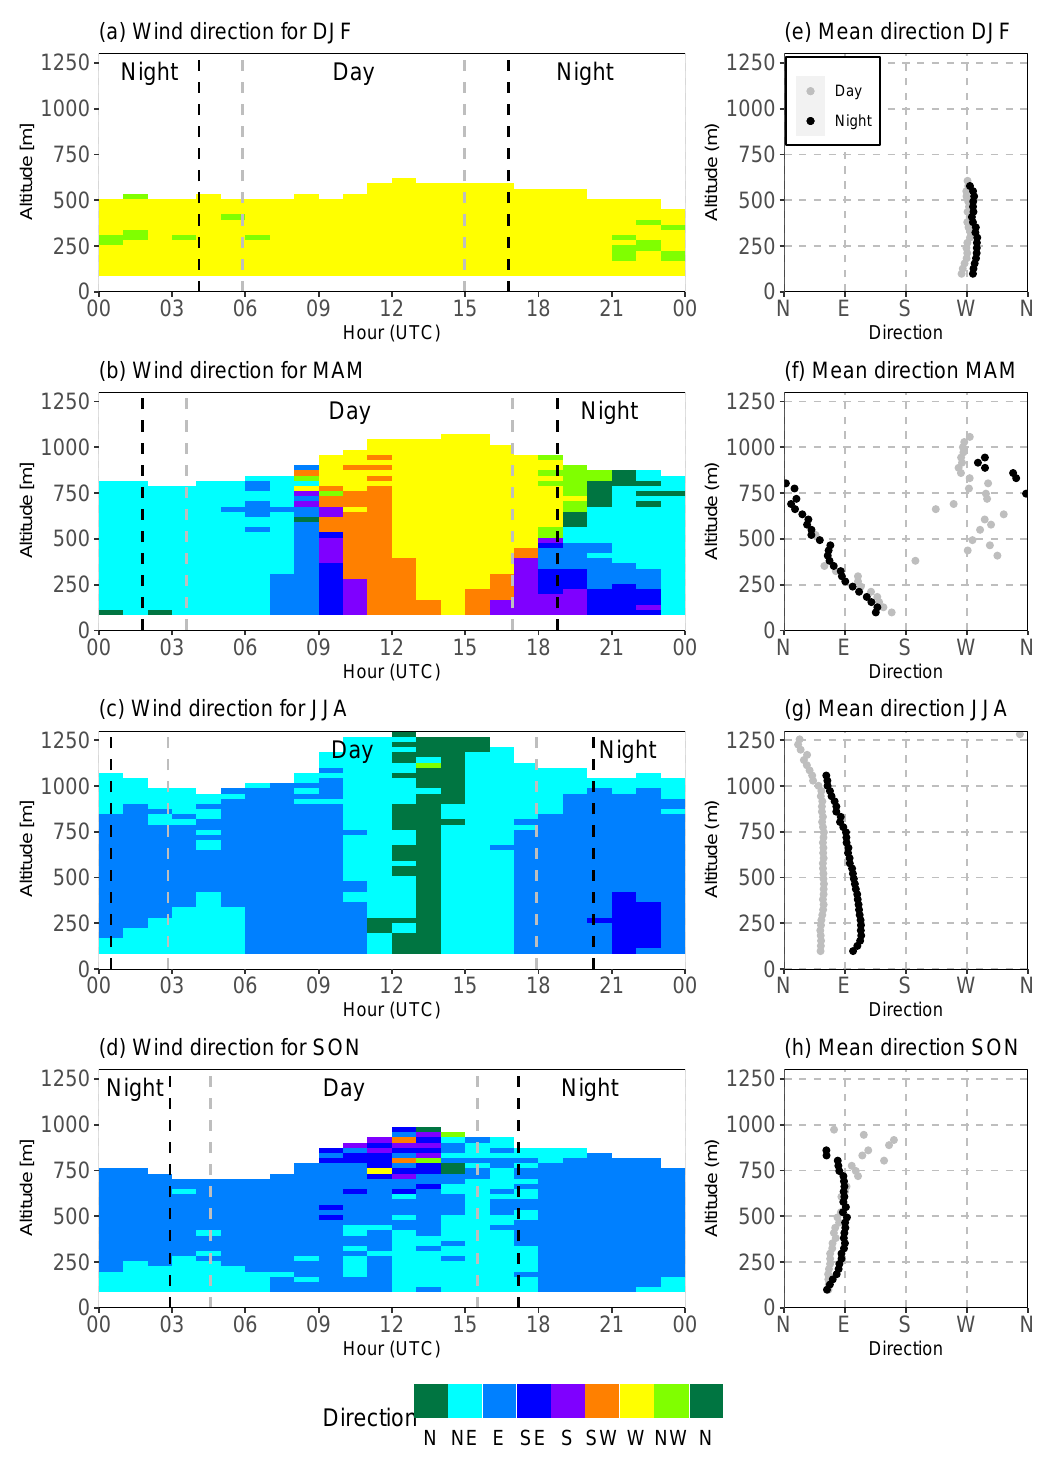
Figure 6. DWL hourly means of horizontal wind directions for December 2019–November 2021 analysed period for all seasons ( a – b ) and the mean direction profiles for daytime and nighttime ( e – h ). During summer, the mean wind direction is mostly from the east and northeast while at around 12 UTC the wind blows from north (Figure 6c). It is again notable that the similarities between DWL data and ERA5 climatology (Figure 8c,g). We speculate that this behaviour may be attributed to some local features that involves topographical aspects and the effect of Bucharest UHI (Urban Heat Island) which requires further in-depth investigations.